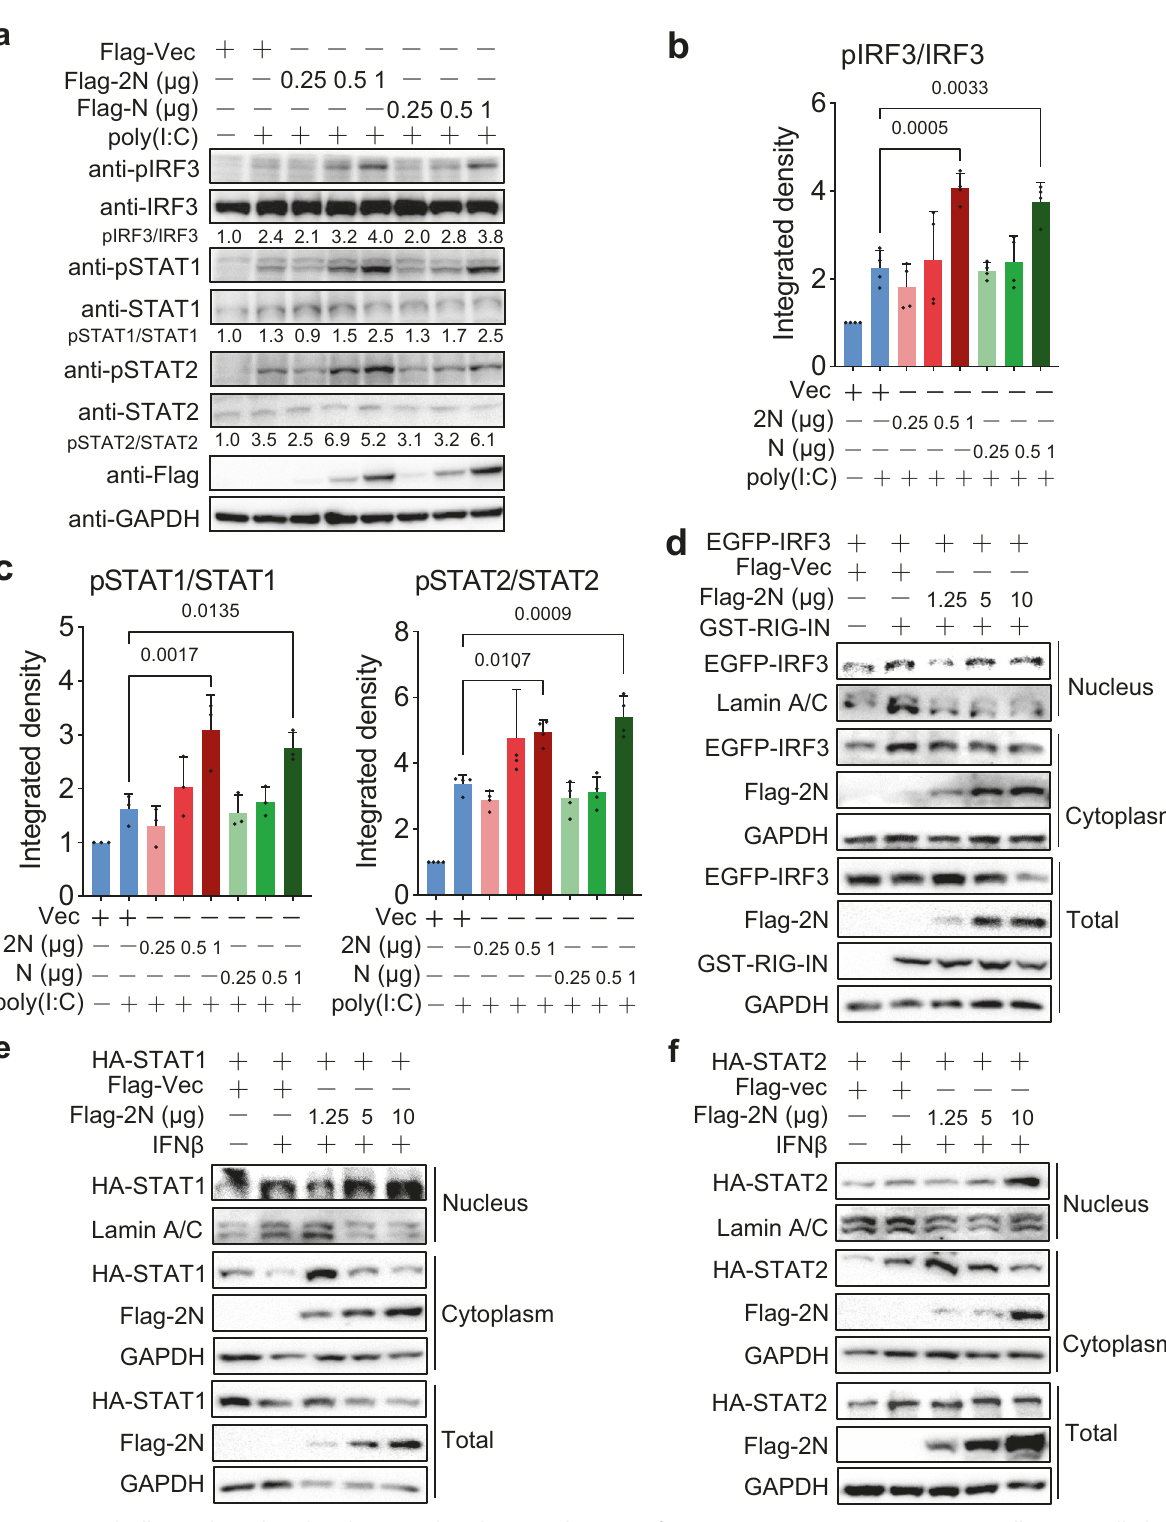
Fig. 2 N proteins dually regulate phosphorylation and nuclear translocation of IRF3, STAT1, or STAT2. a – c HEK293T cells in 24-well plate were co-transfected with the plasmids expressing Flag-tagged SARS-CoV-2 or SARS-CoV N (2N or N) as indicated doses, then treated with or without poly(I:C). At 24 hpt, the expression of N proteins, the endogenous phosphorylation, and total proteins of IRF3, STAT1, or STAT2 were detected by western blot, GAPDH as a loading control ( a ); the gray-scale statistical analysis of phosphorylation levels of IRF3 ( b ) and STATs ( c